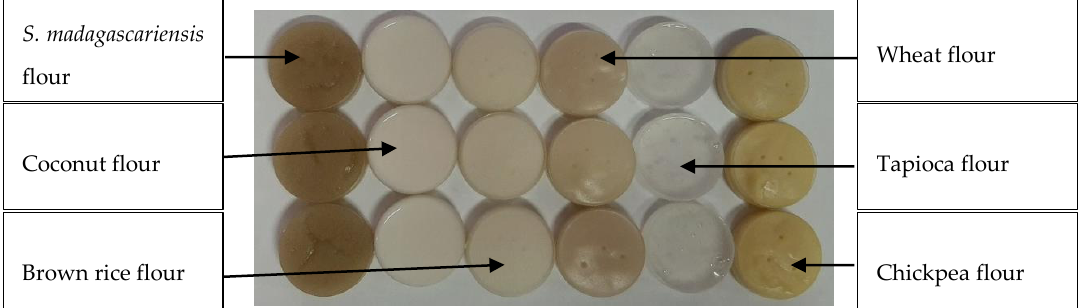
Figure 4. Sample pastes obtained from the rapid visco analyser (RVA) indicating the colour variations between the S. madagascariensis seed flour and the reference flours, for which the pastes were obtained by creating a suspension of flour and water (14% w / w ), heating to a maximum temperature of 91 °C and allowing to cool for 2 h at 25 °C.